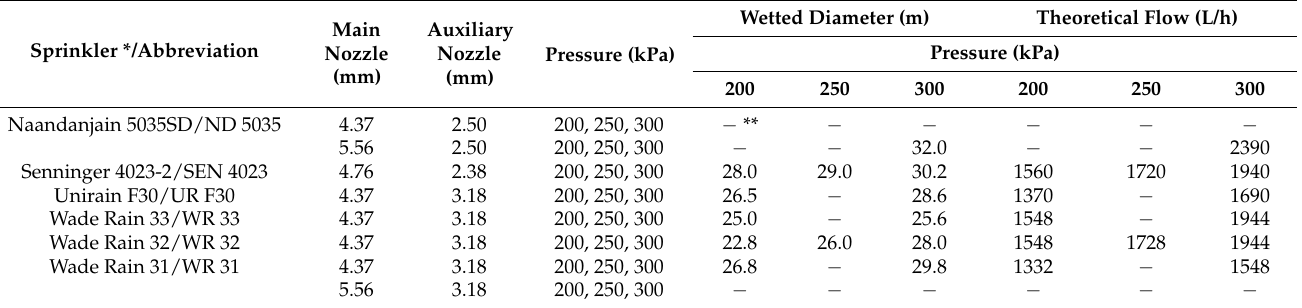
Table 1. Impact sprinklers types used. The features of each sprinkler, main and auxiliary nozzle sizes and the operating pressure of each are